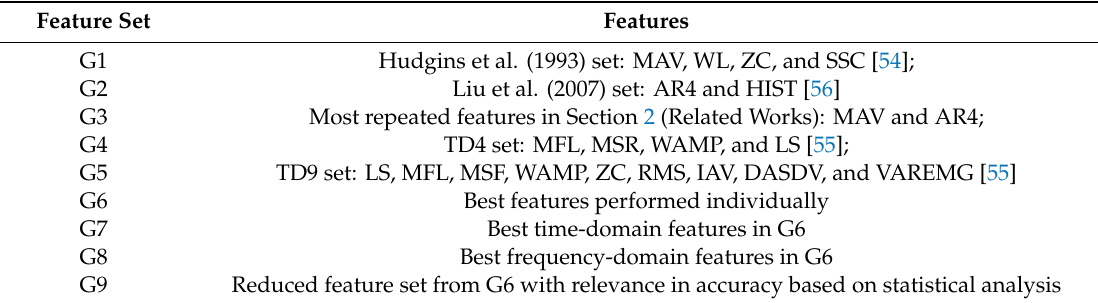
Table 2. Feature Sets organized and applied in this work.